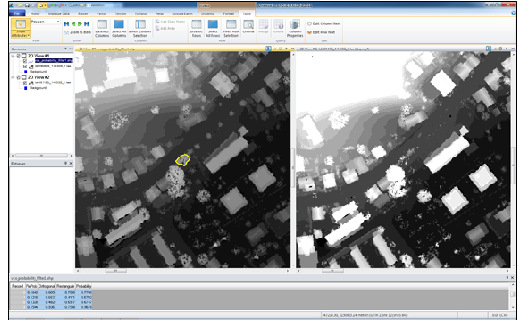
Figure 6. This polygon appears to be a false detection (and would be easier to confirm if colour or false-colour infrared imagery were available as a simultaneous or near-simultaneous